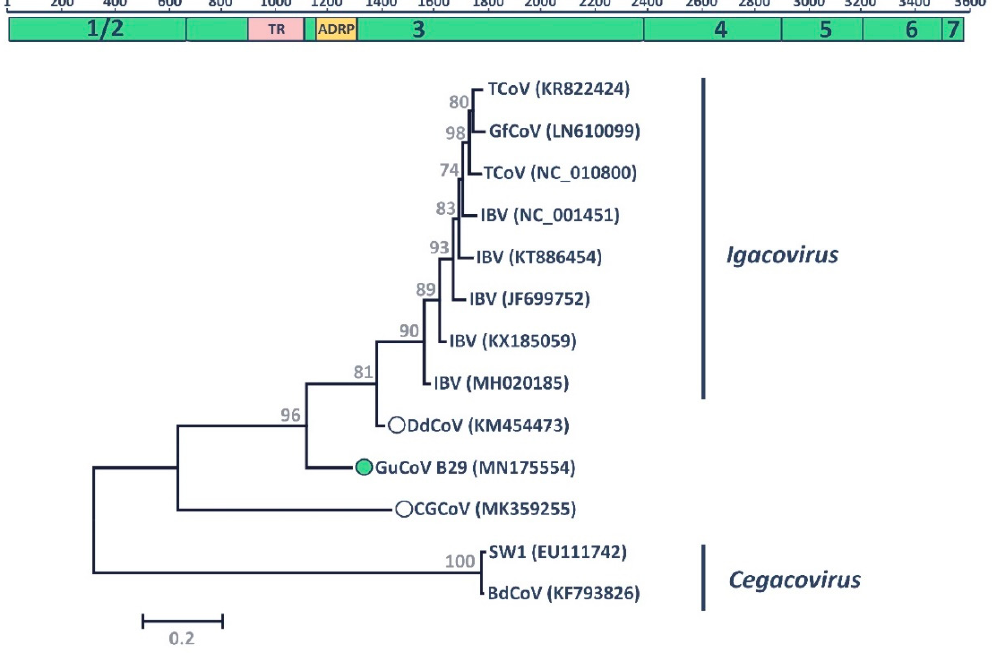
Figure 2. Molecular characteristics of GuCoV B29. The organization of the partial 1a polyprotein of the novel virus is depicted at the top. Identified mature peptides (non-structural proteins, nsp1/2–7) are illustrated by green rectangles. The pink rectangle indicates the area in nsp3 where the tandem repeat (TR) was identified, while the yellow rectangle shows the location of the conserved ADP-ribose 1-“phosphatase (ADRP) replicase domain within nsp3. The scale bar on top represents the amino acid position within the polyprotein. The phylogenetic placement of GuCoV B29 within the genus Gammacoronavirus based on the concatenated alignments of the ADRP and 3C-like proteinase (3CL pro ) (corresponding to nsp5) is shown at the bottom. The two species Igacovirus and Cegacovirus are indicated on the right. Accession numbers of sequences used (SW1: Beluga whale coronavirus; BdCoV: Bottlenose dolphin coronavirus; IBV: Infectious bronchitis virus; TCoV: Turkey coronavirus; GfCoV: Guinea fowl coronavirus; DdCoV: Dominant-duck coronavirus; GuCoV: Gull coronavirus; CGCoV: Canada goose coronavirus) are indicated in parentheses. Recently identified viruses that lack official taxonomic designations are indicated by circles with the virus identified in this study indicated by the filled green circle. The tree was built with the maximum likelihood method [47] using MEGA 7 [43] based on the Le Gascuel model [50], identified as the best-fitting model by the model test in MEGA. A discrete Gamma distribution was used to model evolutionary rate differences among sites, branch lengths are proportional to genetic distances as indicated by the scale bar, and the outcome of the bootstrap analysis [48] is shown next to the nodes.